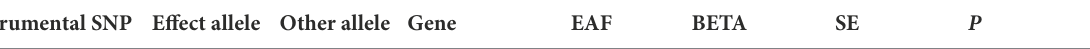
TABLE 3 Instrumental SNPs of NAFLD and F